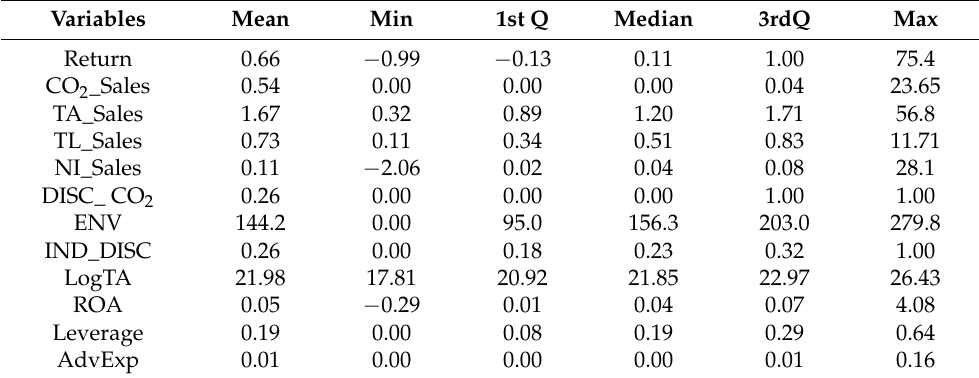
Table 4. Descriptive statistics.